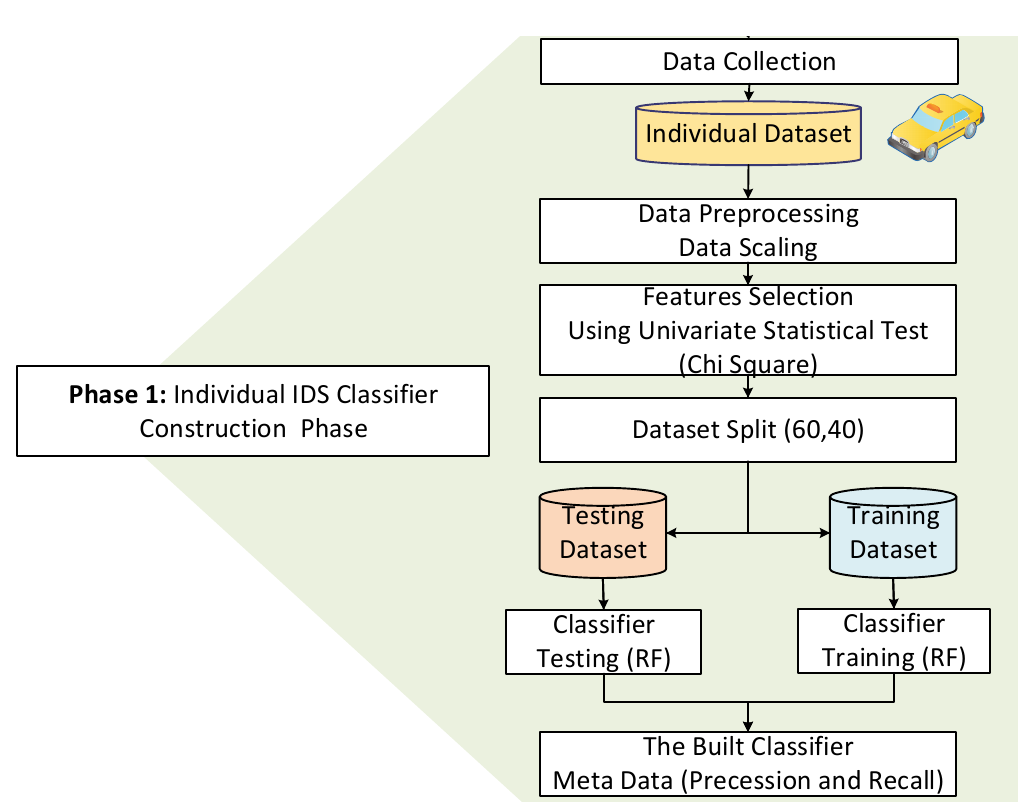
Figure 2. Sharing decision algorithm.